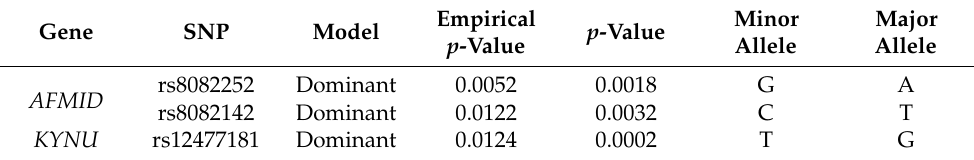
Table 2. Significant